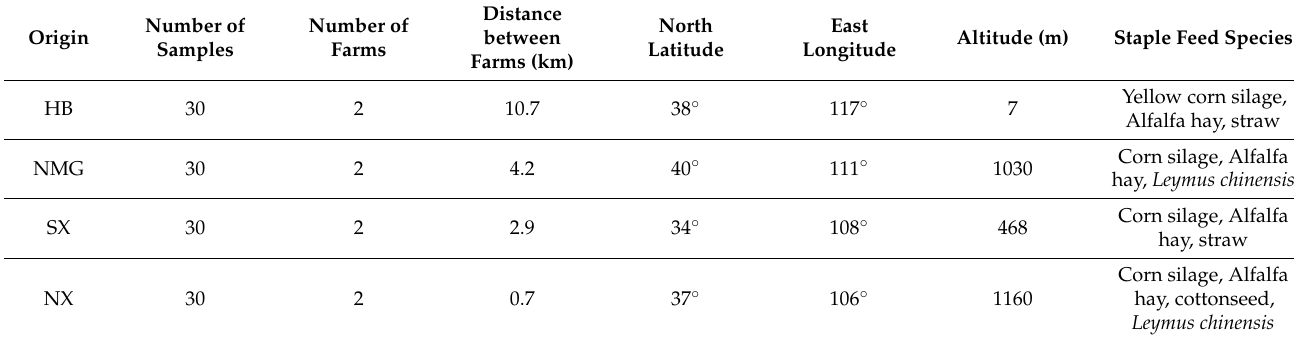
Table 1. Information on dairy farms in four regions of